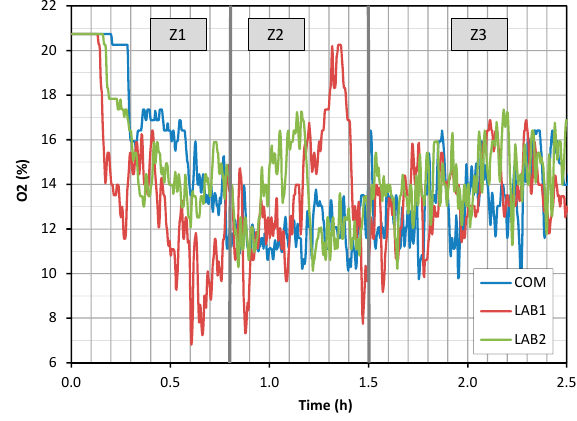
Figure 8. Oxygen concentration in the flue gas.